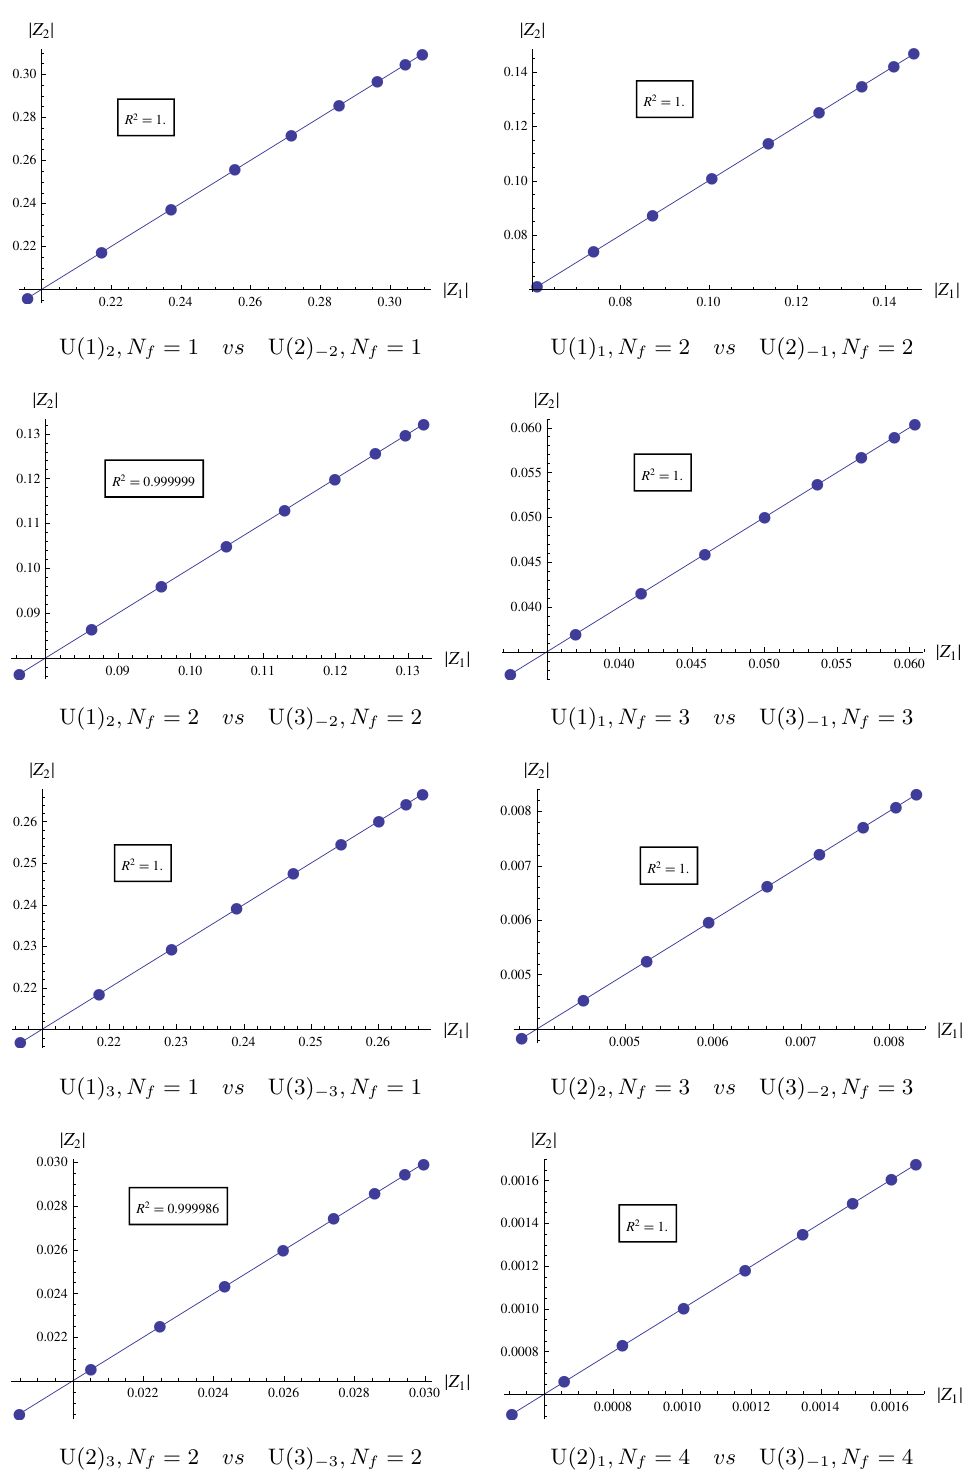
Figure 4 . A comparison of the magnitude of the partition functions with FI deformation ( (cid:17) ) for 8 dual pairs and values of (cid:17) from : 1 to : 9 and a best (cid:12)t line, which, to the accuracy of the numerical evaluation, is of slope 1 and intercept